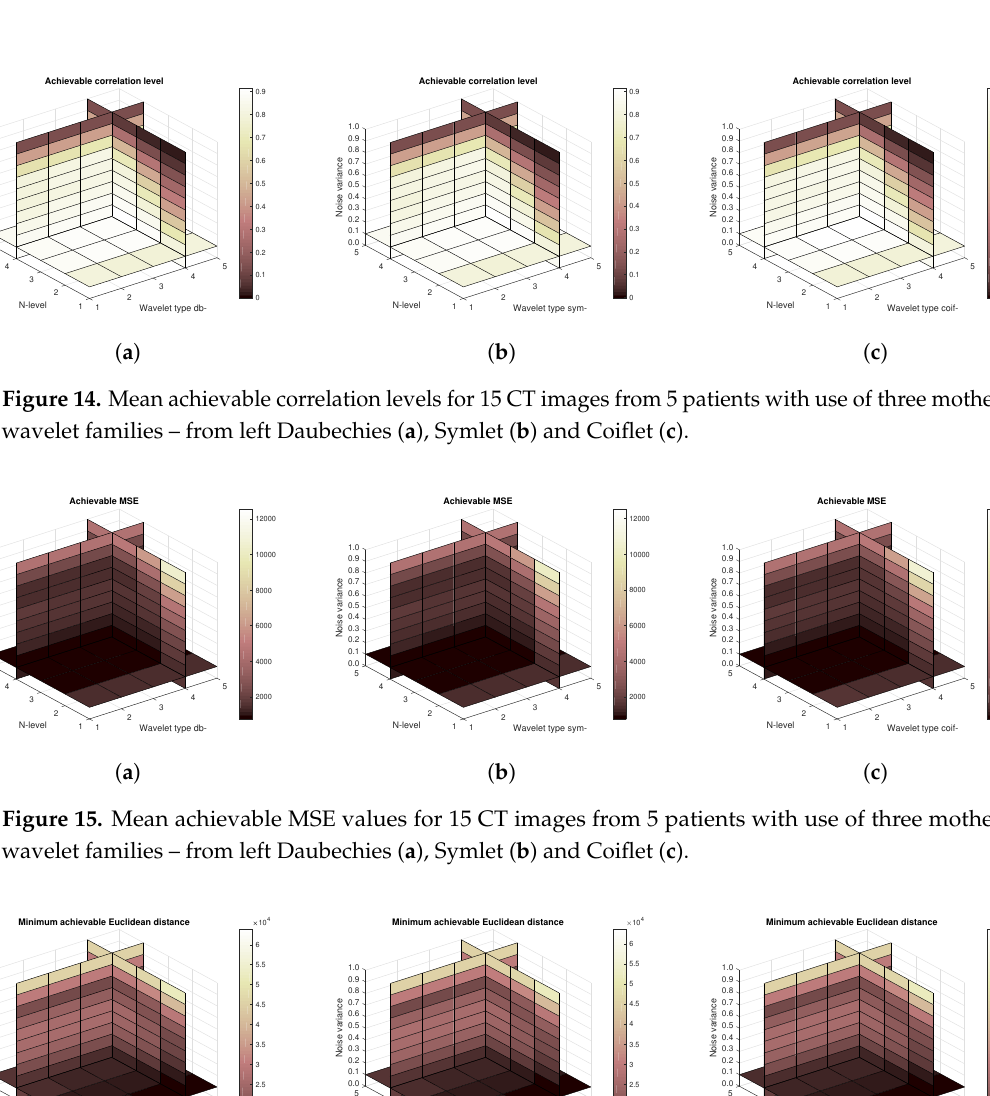
50.20.30.4 0.00.1